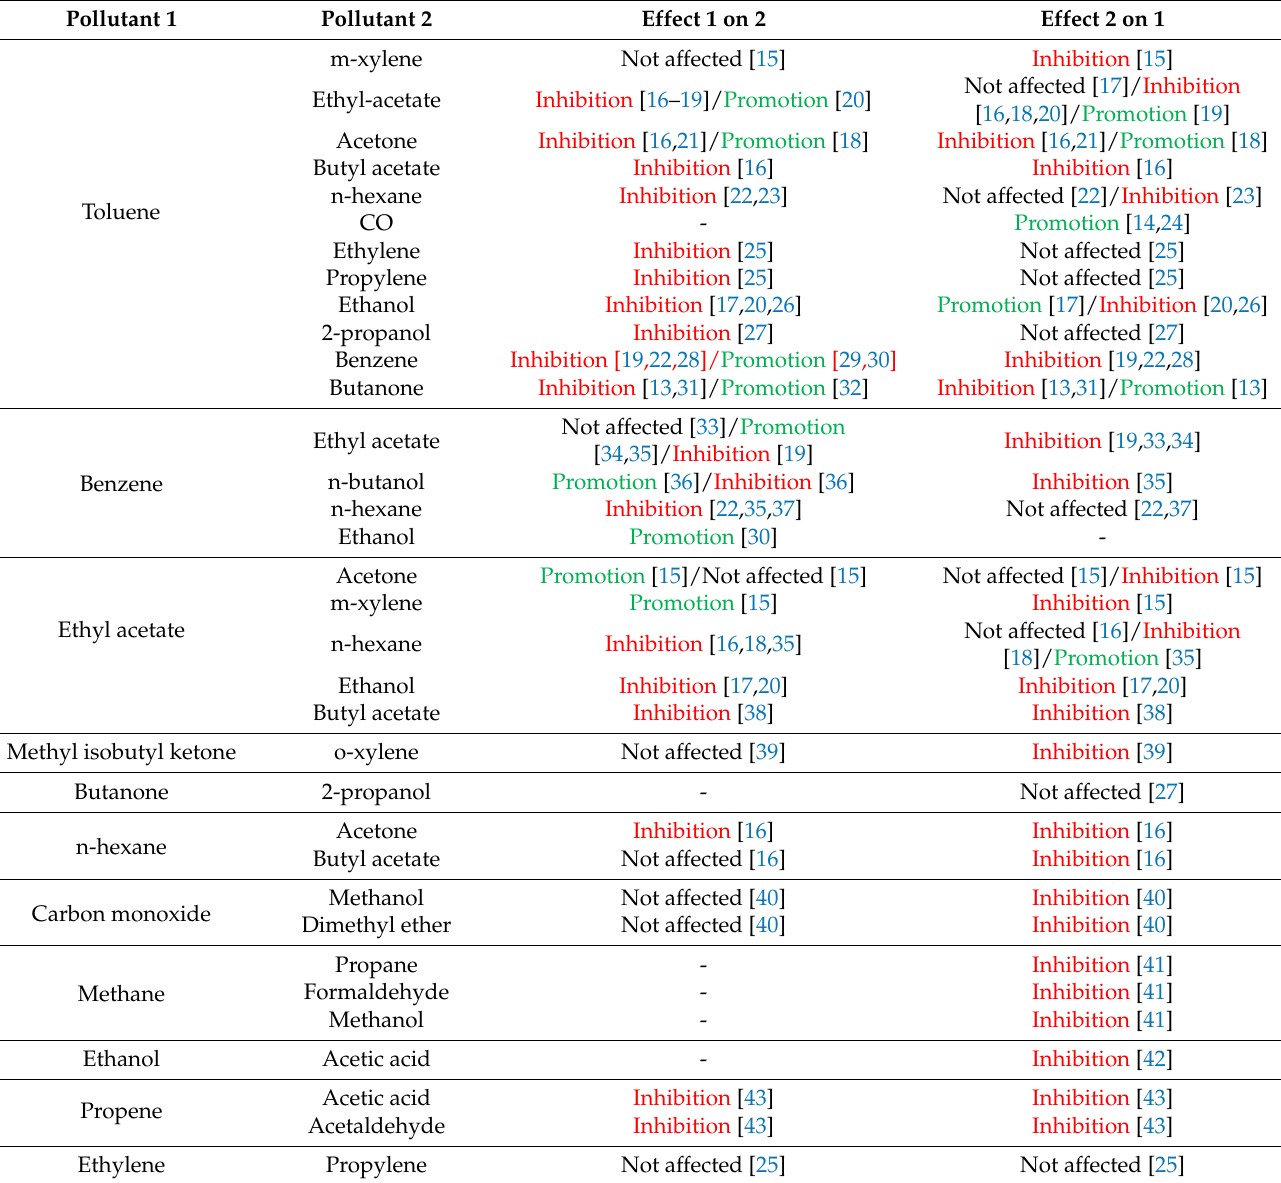
Table 1. Summary of catalytic effects reported for the oxidation of VOCs